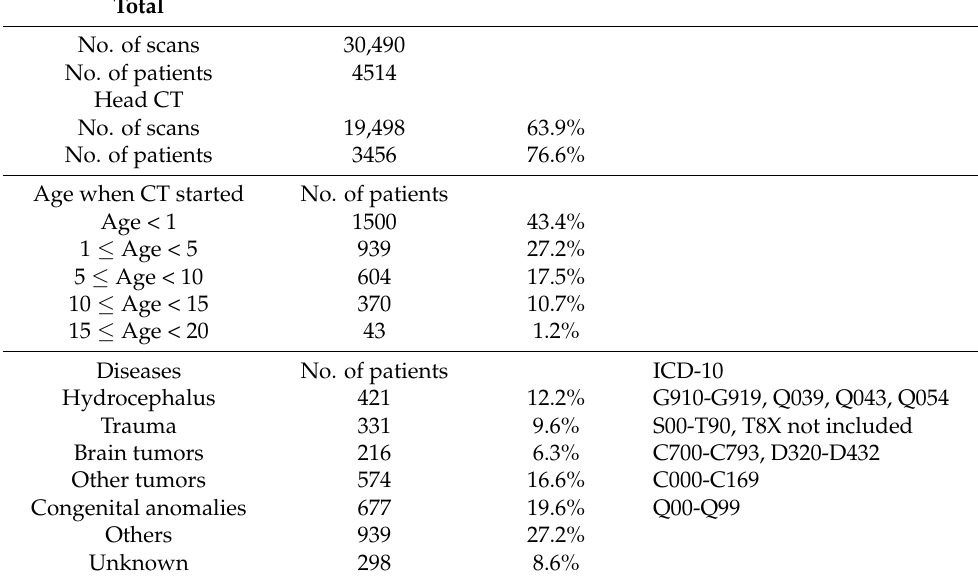
Table 1. Characterization of the number of CT scans and patients in a children’s